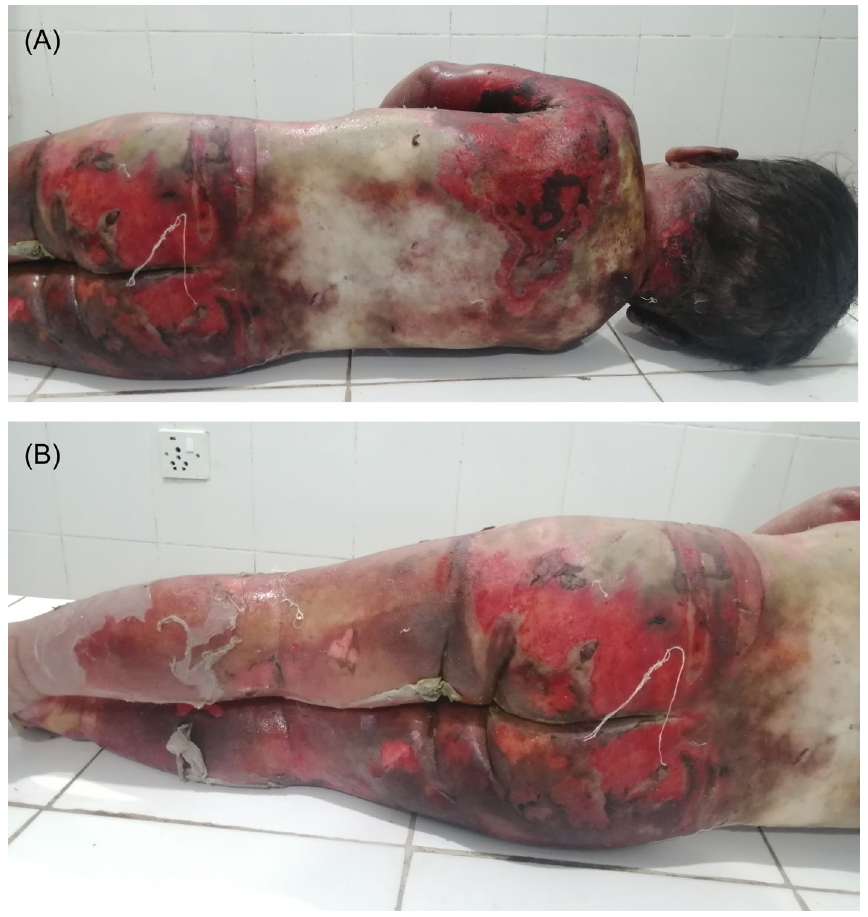
Figure 2. A and B. The back of the body and lower limbs showing the area involved in